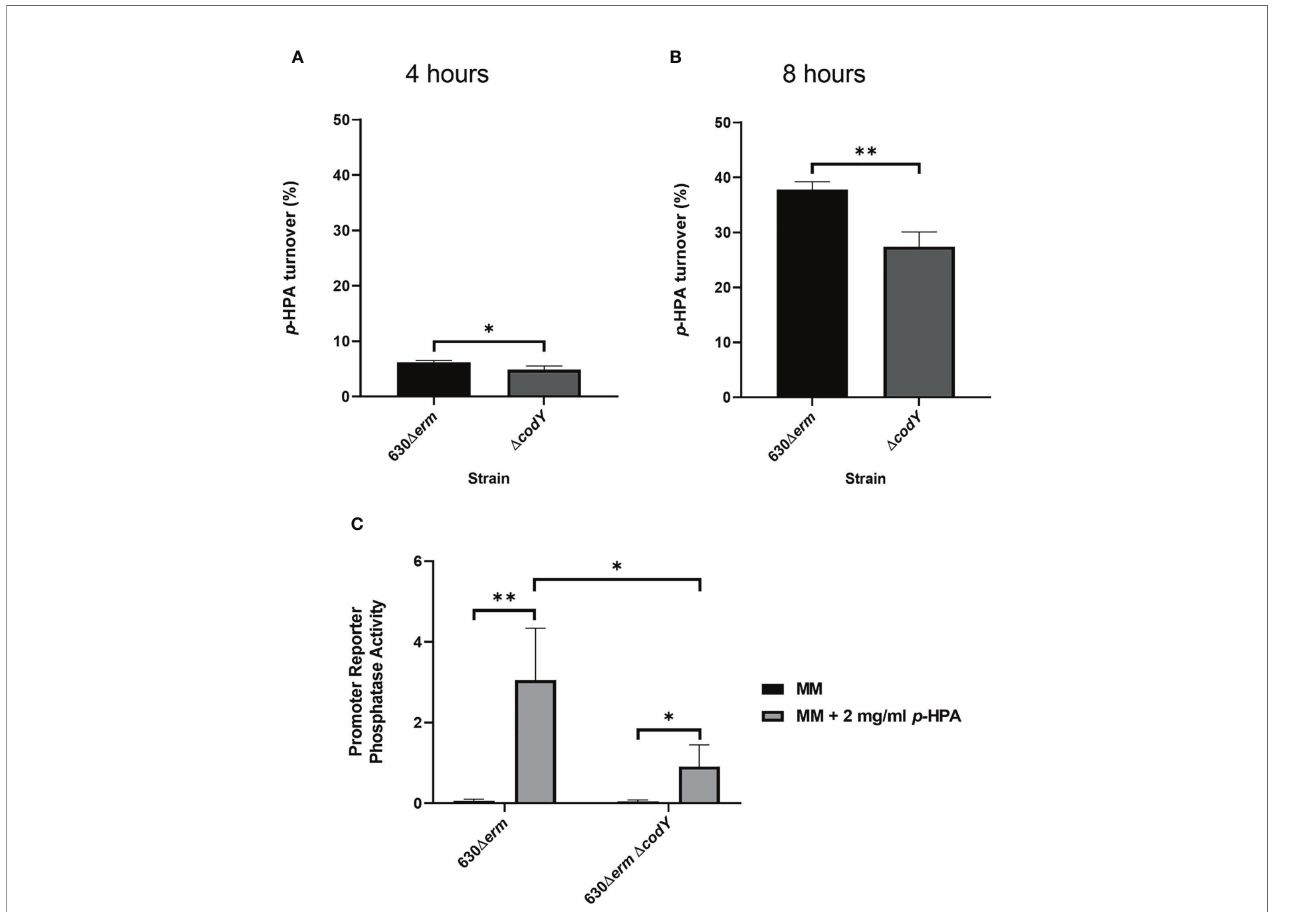
FIGURE 3 | Mutation of codY reduces p -HPA conversion to p -cresol via a reduction in the expression of the hpdBCA operon. (A, B) 630 D erm and 630 D erm D codY were grown in de fi ned media with 2 mg/ml p -HPA for 8 h, with the samples taken at 4 and 8 h for HPLC analysis of p -HPA and p -cresol concentration. The turnover percentage was calculated as ( p -cresol/ p -HPA + p -cresol) normalized to growth by OD 590 nm . (C) Expression from the hpdBCA promoter was assessed by phosphatase activity in 630 D erm and 630 D erm D codY carrying P hpdB - phoZ grown for 4 h in DM ±2 mg/ml p -HPA. Phosphatase activity was calculated by the formula [OD 420 nm – (OD 550 nm x 1.75)] × 1,000/ t (min) × OD 590 nm × volume of cells (ml). Data represents the mean and standard deviation of three independent replicates. Statistical analysis was carried out by linear regression and used to determine signi fi cant differences between normalized p -HPA turnover and promoter reporter activity for each strain. * p < 0.05, ** p <